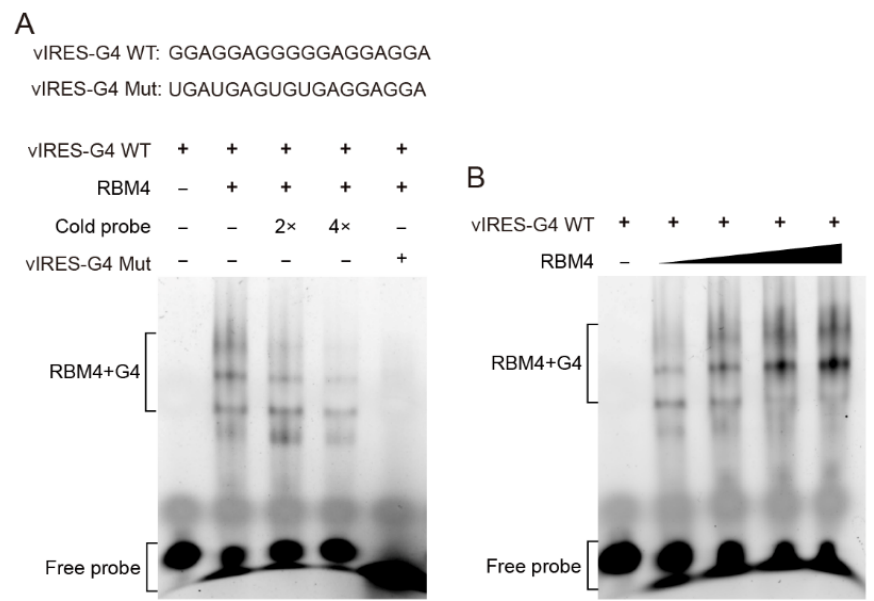
Figure 3. RBM4 specifically bound to the G4 structure in vIRES. ( A ) EMSA analysis of the binding between RBM4 and the G4 structure in the vIRES. ( B ) The binding between RBM4 and G4 was gradually enhanced with the increase of RBM4 protein level.